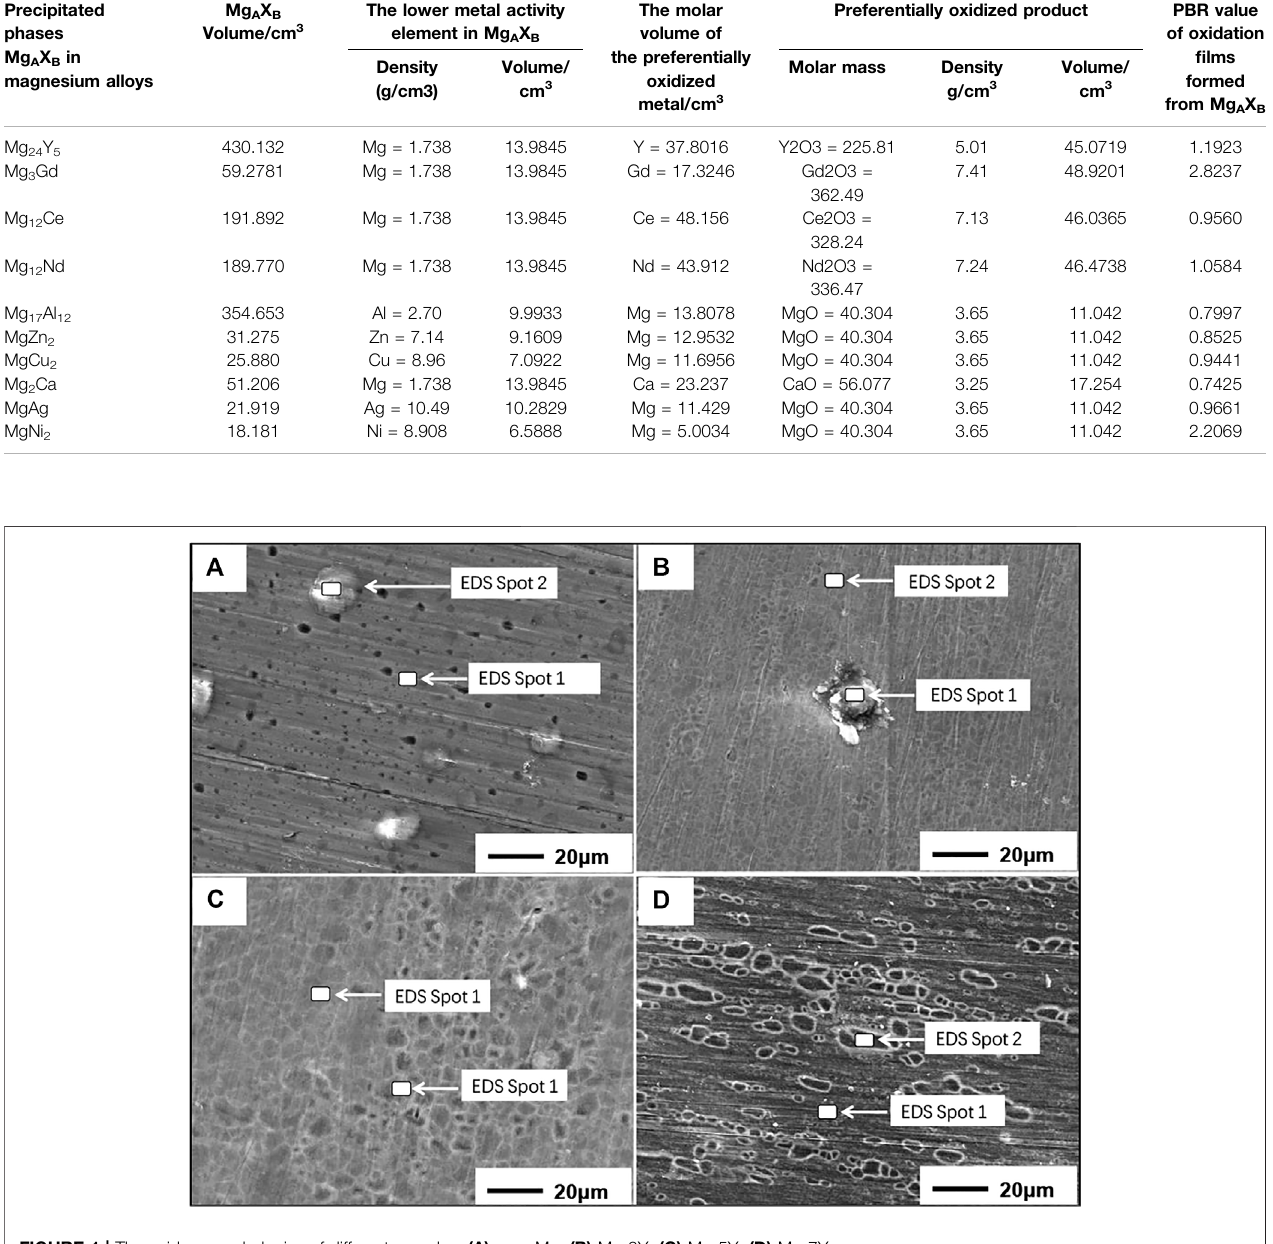
Frontiers in Materials |